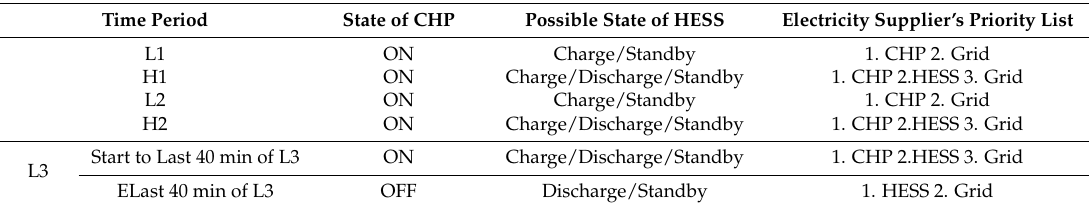
Table 2. Daily electricity control strategy in